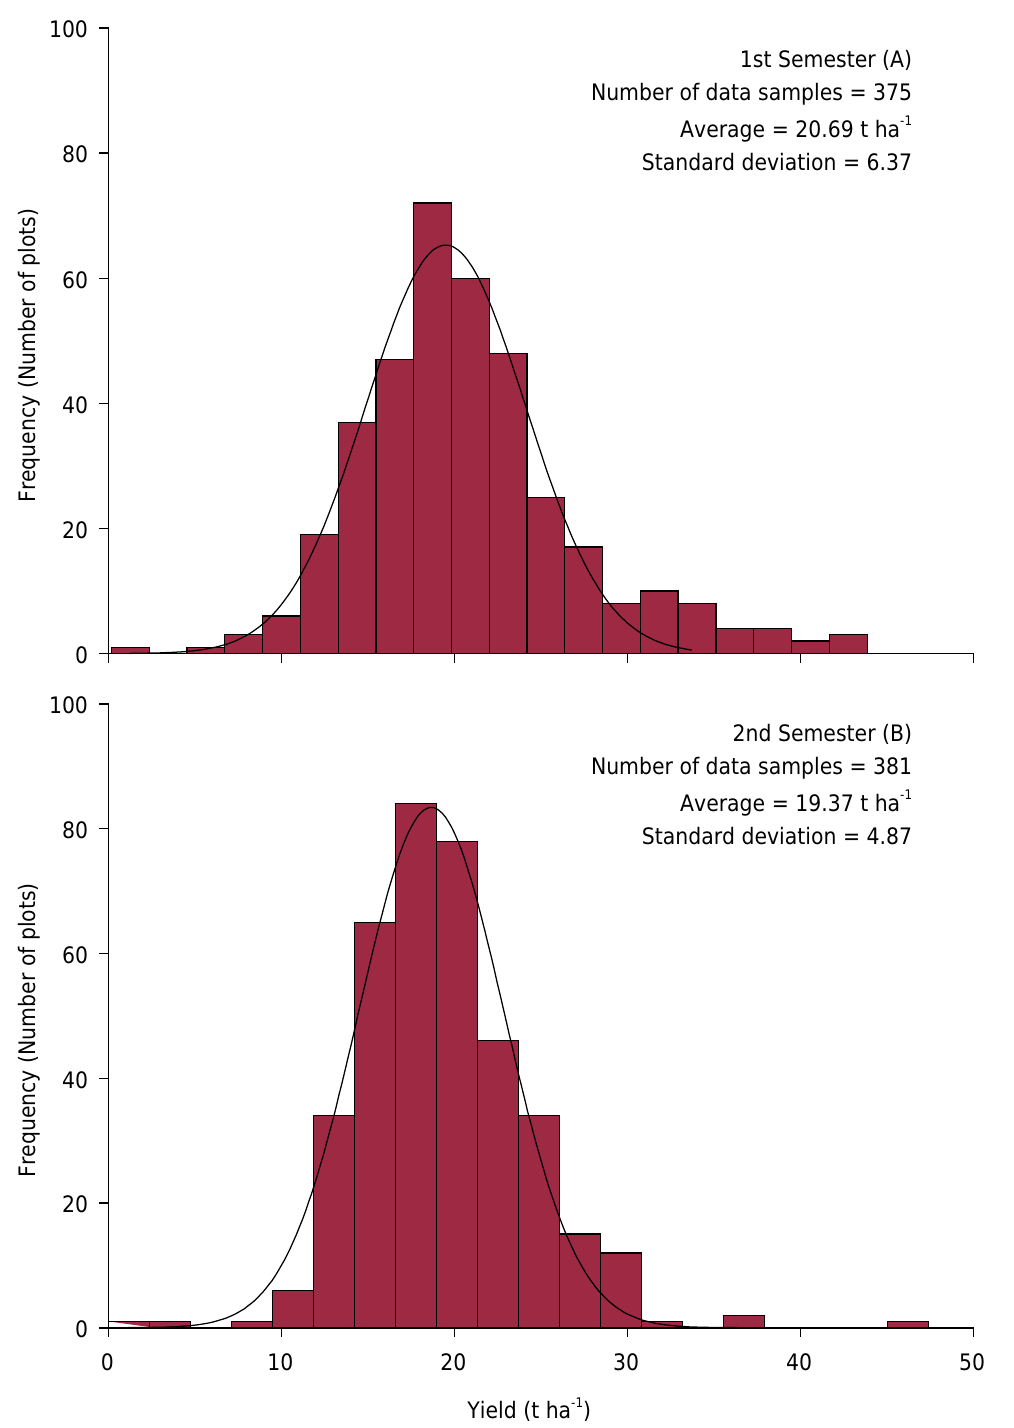
Figure 1. Histogram of distribution and normal curve of semiannual fruit yield in plots cultivated with ‘Prata’ banana under fertigation from 2010 to